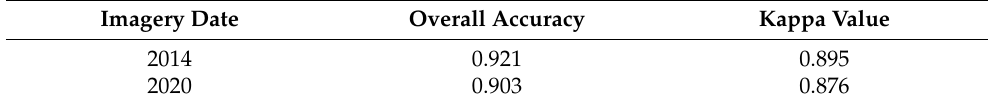
Table 1. Classification accuracies for 2014 and 2020 of Sugarloaf